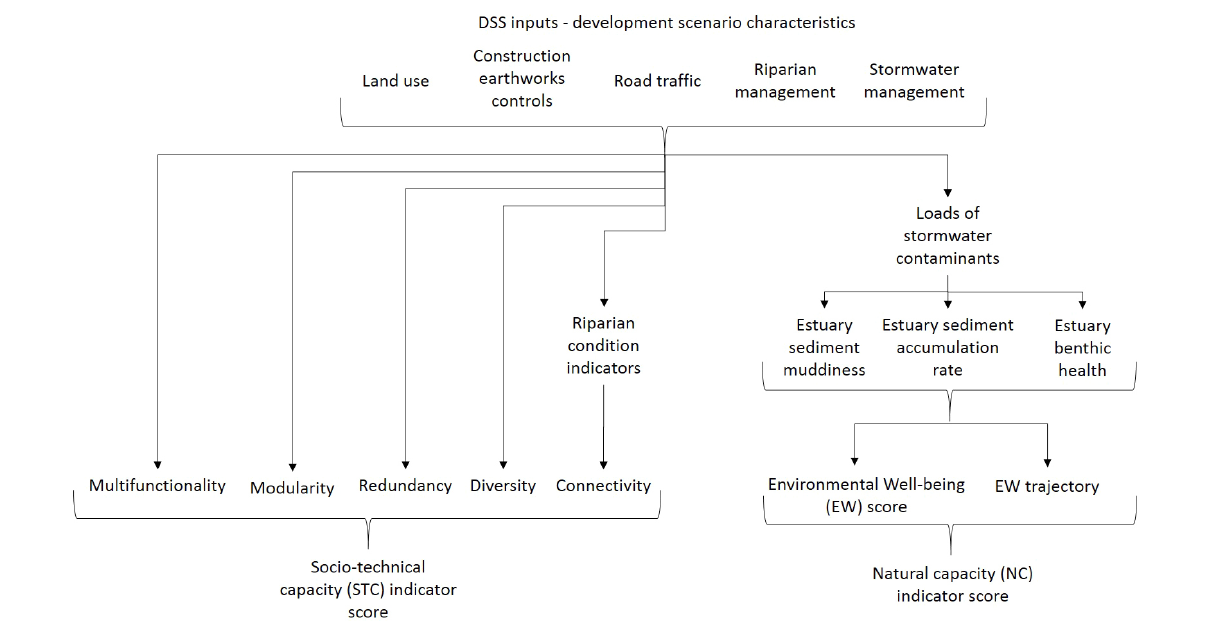
Fig. 3 . Relationships between decision support system (DSS) inputs, predictions of relevant biophysical indicators, and the calculation of resilience indicator